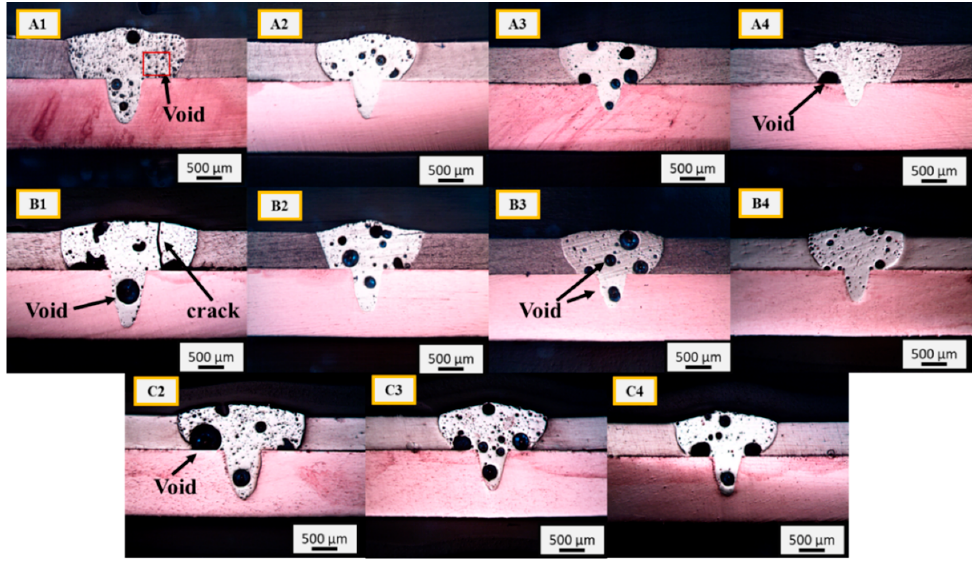
Figure 7. Optical micrographs of the weld transverse cross-section; (A1) power = 1500 W, welding speed = 15 mm/s; (A2) power = 1500 W, welding speed = 20 mm/s; (A3) power = 1500 W, welding speed = 25 mm/s; (A4) power = 1500 W, welding speed = 30 mm/s.; (B1) power = 1600 W, welding speed = 15 mm/s; (B2) power = 1600 W, welding speed = 20 mm/s; (B3) power = 1600 W, welding speed = 25 mm/s; (B4) power = 1600 W, welding speed = 30 mm/s ; (C2) power = 1700 W, welding speed = 20 mm/s; (C3) power = 1700 W, welding speed = 25 mm/s; (C4) power = 1700 W, welding speed = 30 mm/s.